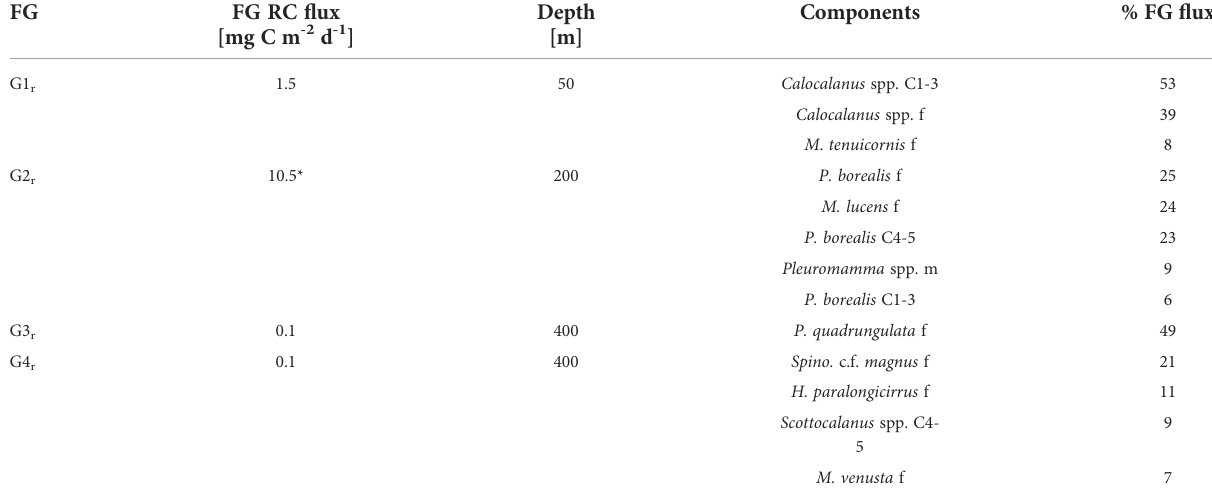
TABLE 2 Percentage contribution of most important (>5% FG fl ux) regular migrants within respective functional groups to total respiratory carbon (RC) fl ux across reference